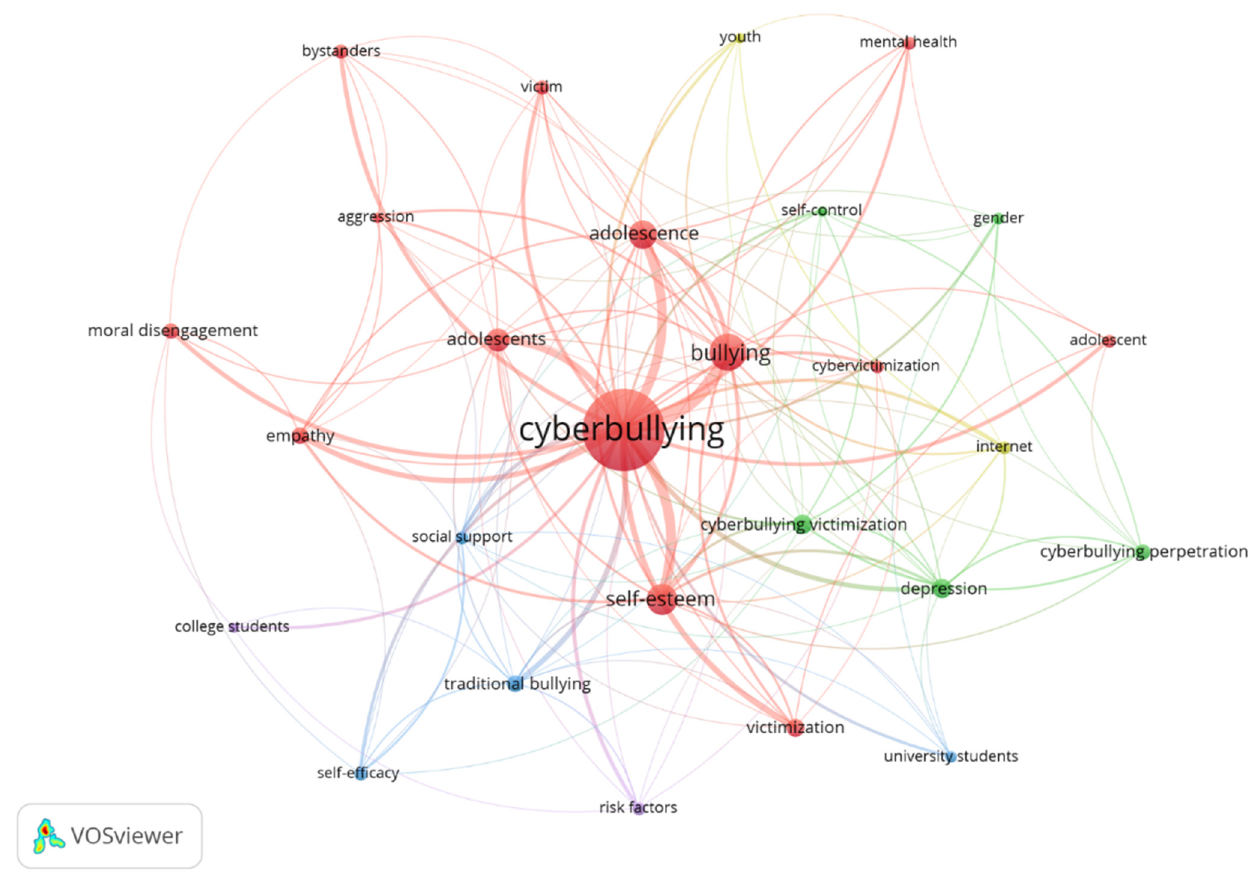
Figure 4. Keywords most used by the co-authors.